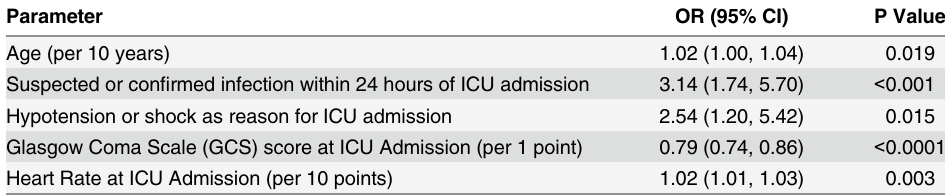
Table 5. Rwanda-Mortality Probability Model